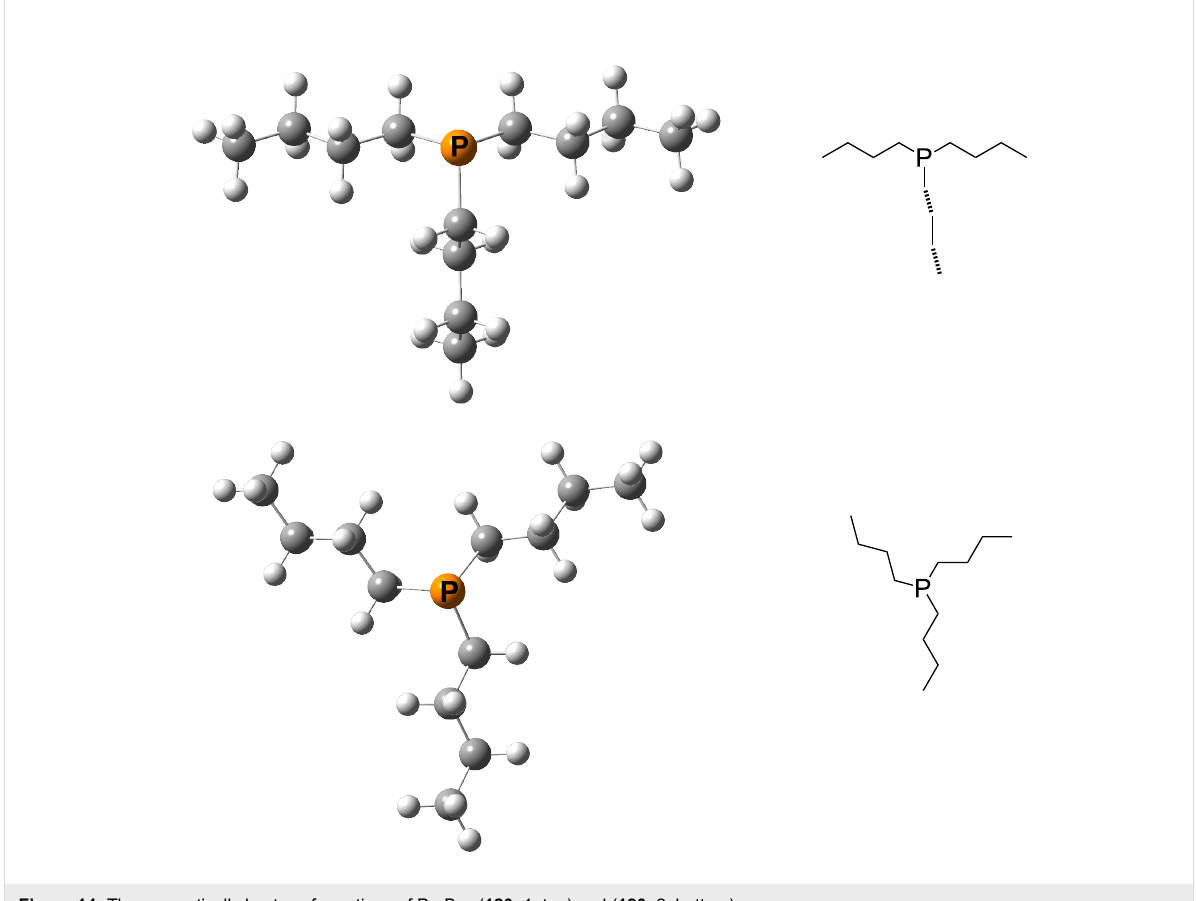
Figure 14: The energetically best conformations of P n -Bu 3 ( 120 _1, top) and ( 120 _2, bottom).